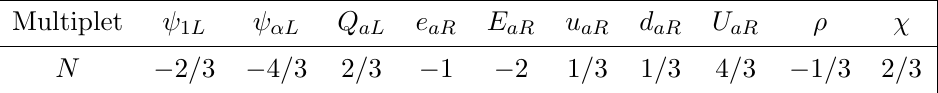
Table 1 . N -charge of particle multiplets.